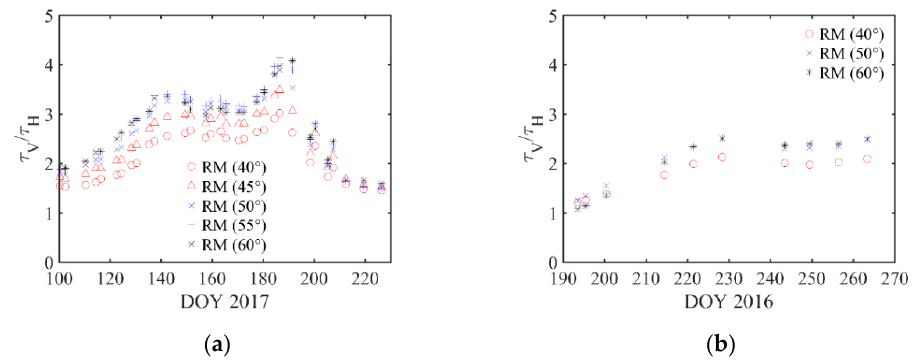
Figure 8. Ratio between the retrieved vegetation optical depth ( τ ) at H and V polarization at different incidence angles from the gridded plot T B data for the wheat ( a ) and mustard vegetation stand ( b ).